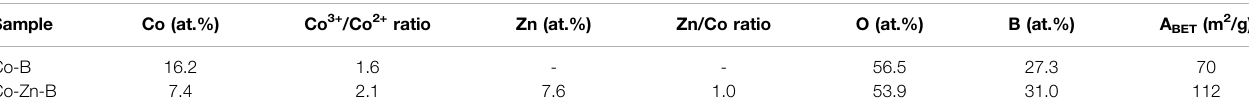
TABLE1| Atomicpercentageofcobalt(Co),oxygen(O),boron(B)andzinc(Zn),Metal/Cobalt(M/Co)andCo 3+ /Co 2+ ratios,obtainedbyXPS,andareaBET(A BET ),obtained from N 2 -adsorption isotherms. Sample Co